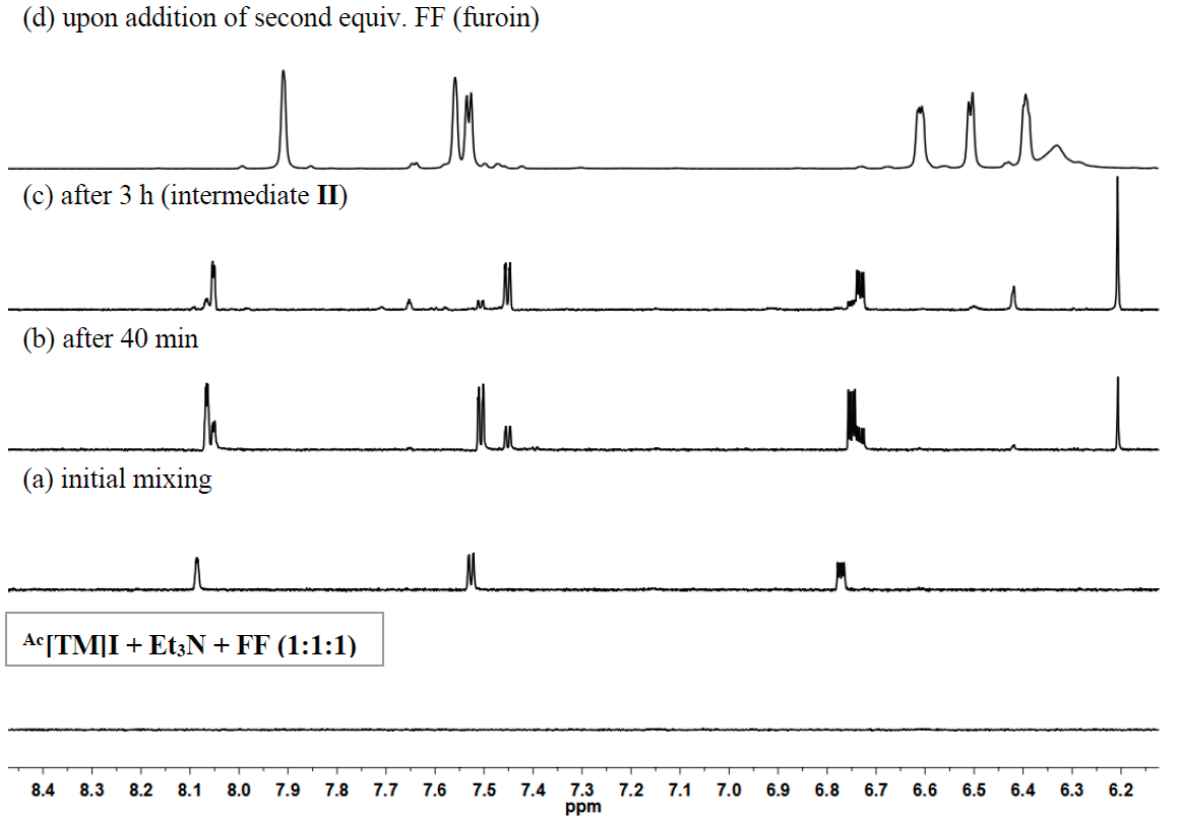
Figure 5. Overlay of 1 H NMR (DMSO- d 6 ) spectra in the furan and methide proton region of the reaction of Ac [TM]I + Et 3 N + FF (1:1:1) at 80 °C leading to formation of intermediate II and furoin (upon addition second equivalent of